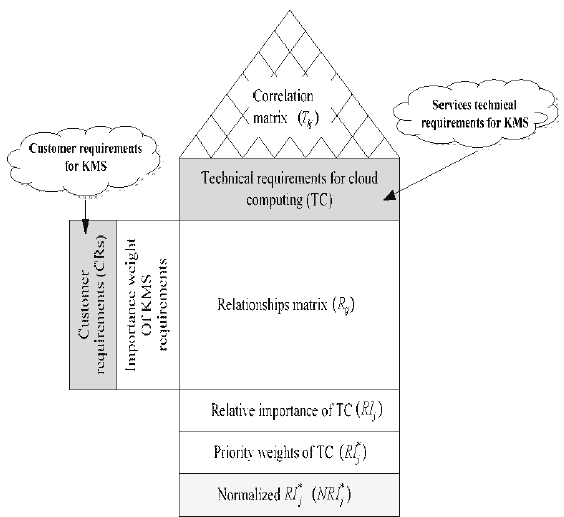
Fig. 3. The AHP-HOQ for the cloud computing selection problems.